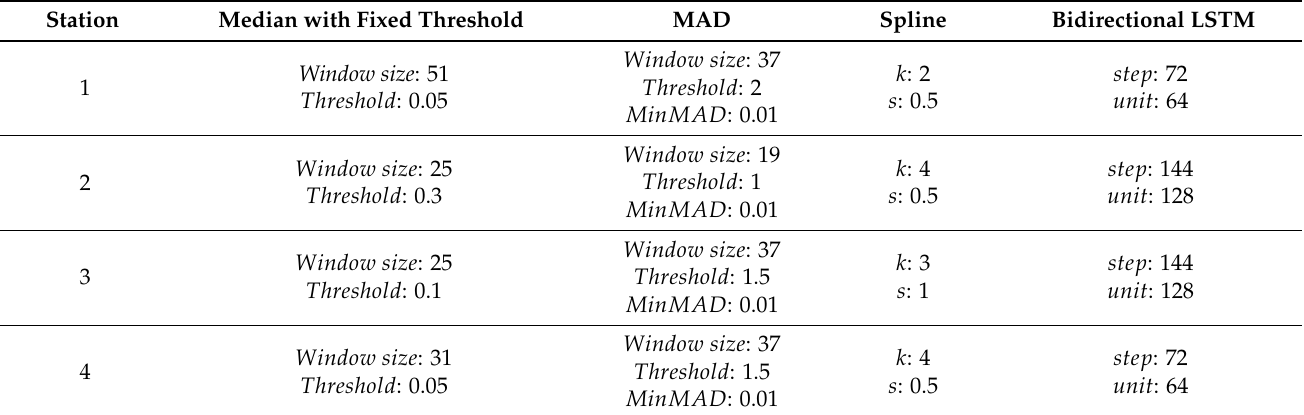
Table 2. anomaly detection and data filling